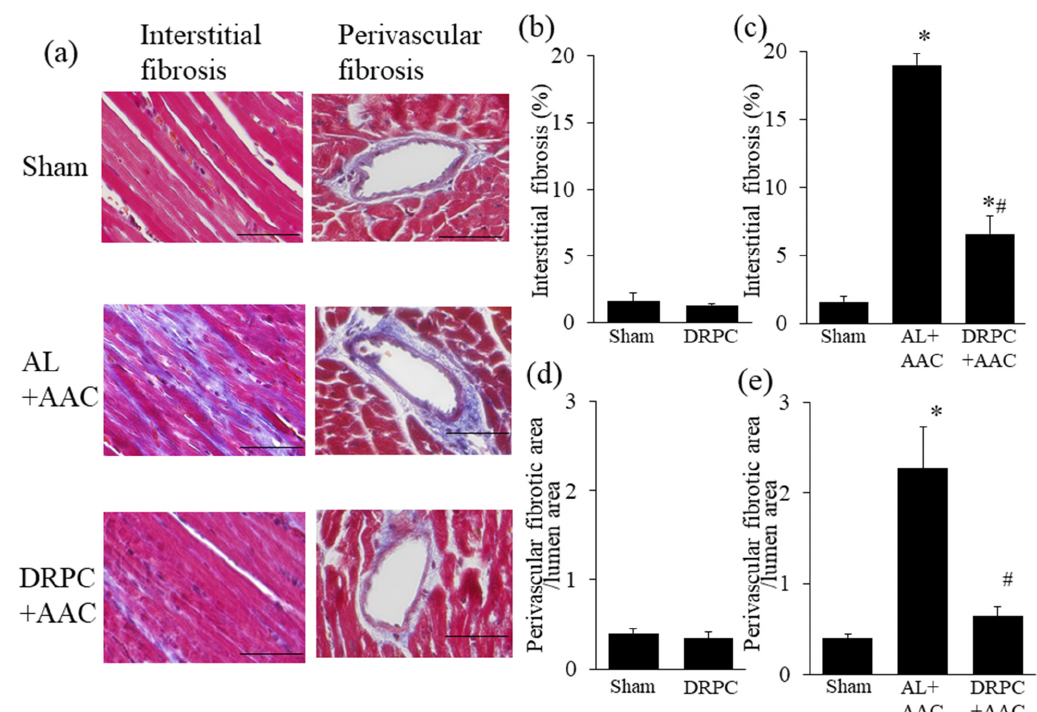
Nutrients 2021 , 13 , x FOR PEER REVIEW Figure 4. Effects of dietary restriction preconditioning on pressure overload-induced interstitial and perivascular fibrosis in cardiac tissue. ( a ) Representative photomicrographs of Masson’s trichrome-stained left ventricular cross-sections 2 weeks after surgery. Bars indicate 50 μ m. Ratio of interstitial fibrosis in the left ventricle before ( b ) and 2 weeks after surgery ( c ) (before surgery, Sham: n = 5, DRPC: n = 6, after surgery, Sham: n = 6, AL+AAC: n = 6, DRPC+AAC: n = 6). Degree of perivascular fibrosis in the left ventricle before ( d ) and 2 weeks after surgery ( e ) (before surgery, Sham: n = 6, DRPC: n = 6, after surgery, Sham: n = 6, AL+AAC: n = 6, DRPC+AAC: n = 6). * p < 0.01 versus Sham. # p < 0.01 versus AL+AAC.